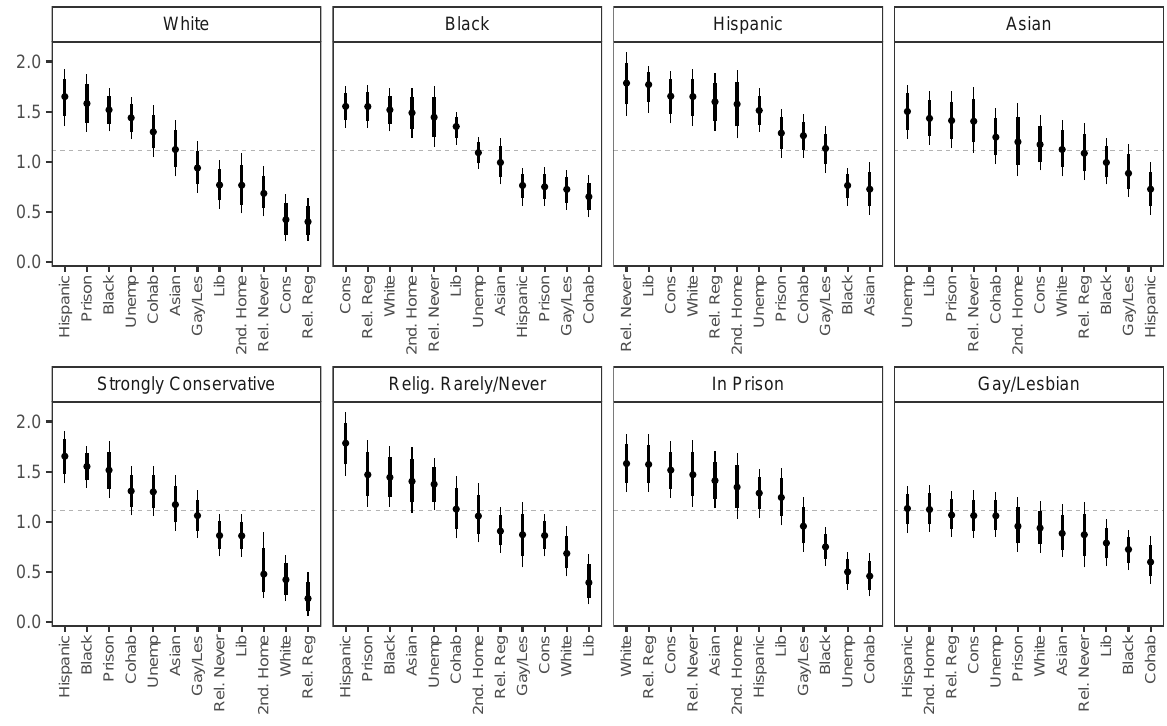
Figure 6: Variation in individuals’ distances to pairs of groups. Notes: Dots represent posterior medians of estimated D -values. Thin and thick vertical lines, respectively, show the 90 percent and 95 percent credible intervals. Dashed horizontal line in gray shows the posterior median of the average D -values across all pairs of